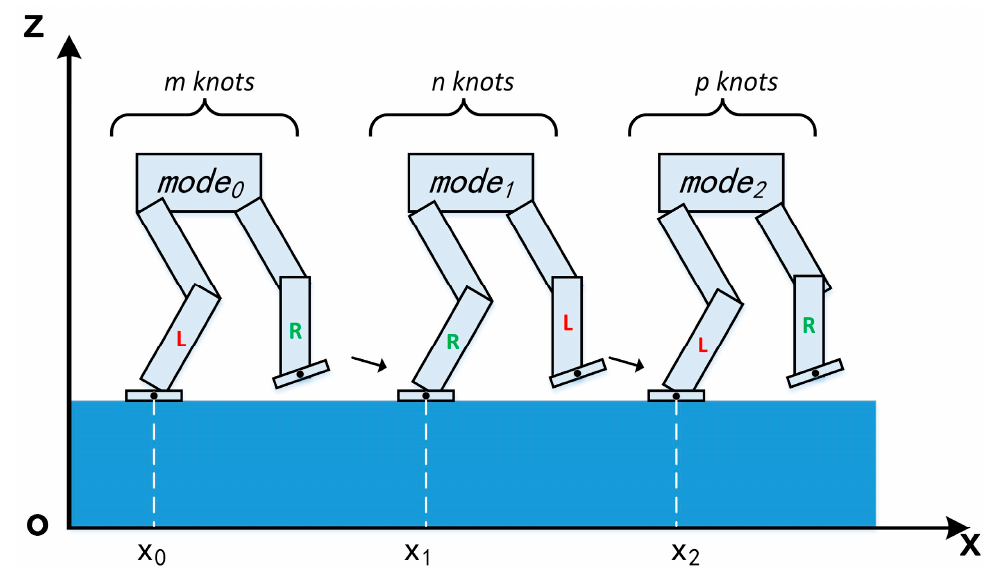
Figure 1. Decision variables of three footholds in one single gait planning.